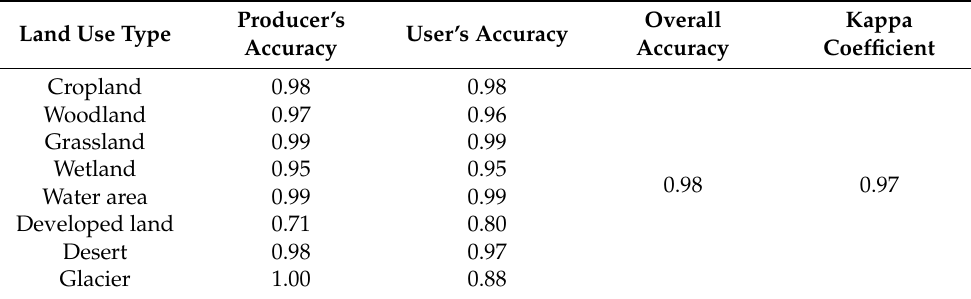
Table 5. Validation parameters for the results of the simulation.